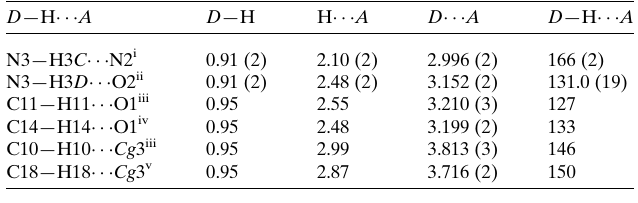
Table 1 Hydrogen-bond geometry (A˚ , (cid:3) ).